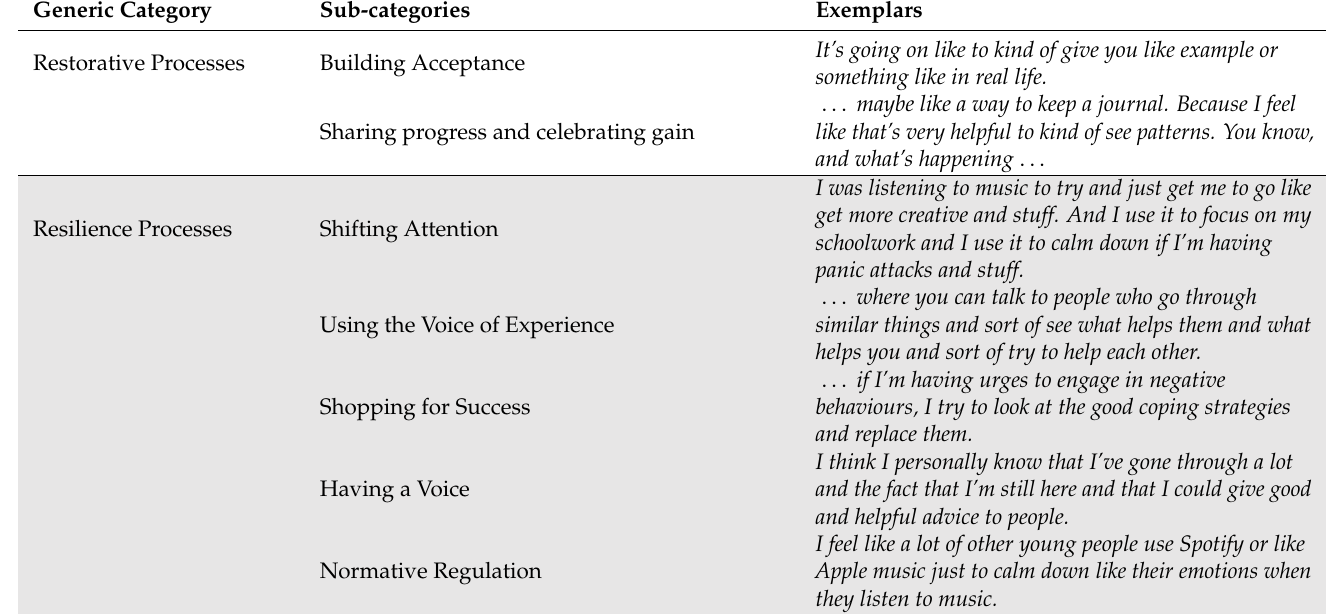
Table 9. Exemplars and categories related to empowerment recovery